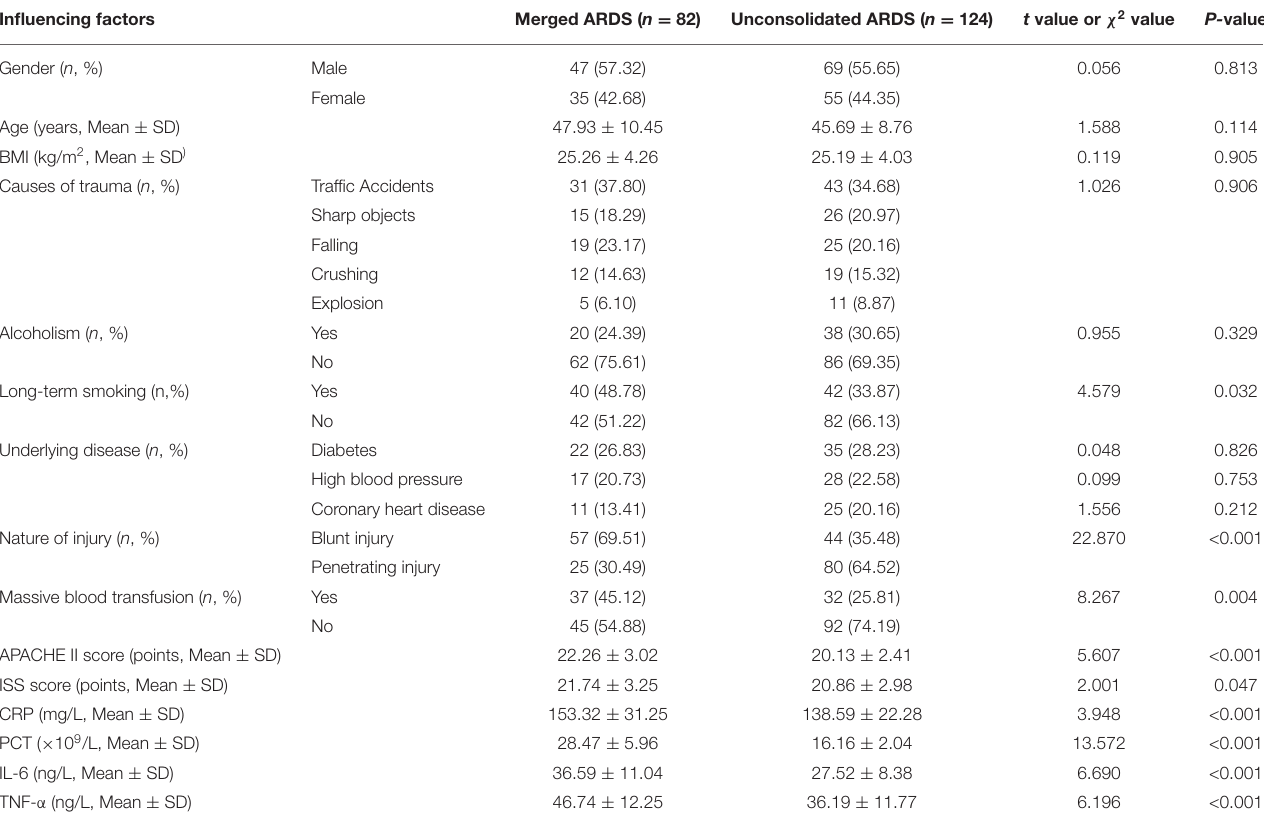
TABLE 1 | Univariate analysis of thoracic trauma combined with